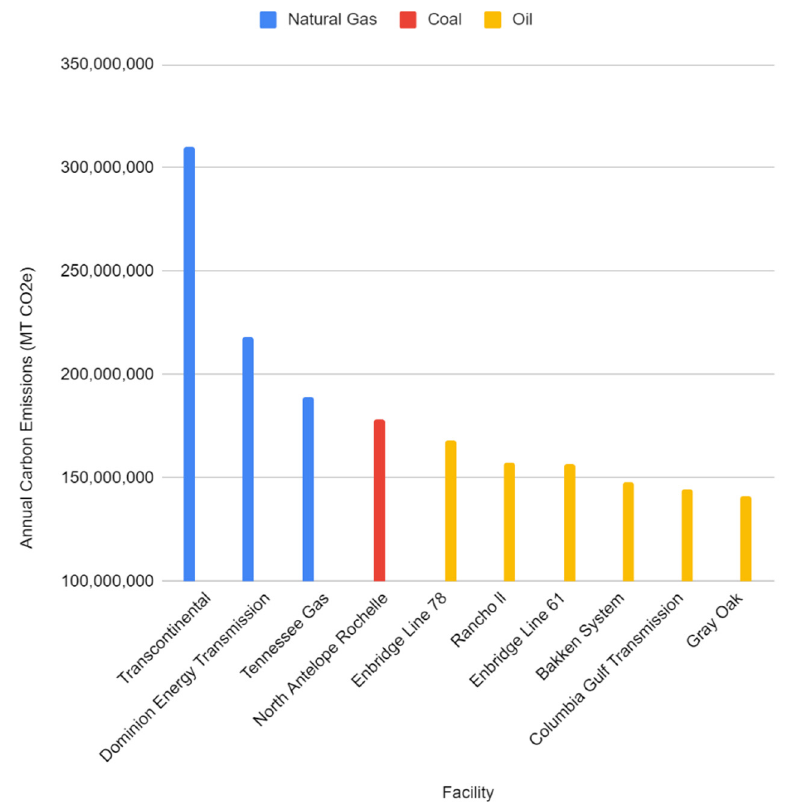
Figure 21. Overall Top 10 CO 2 Emission Bottlenecks Across All Fossil-Fuel Industries.